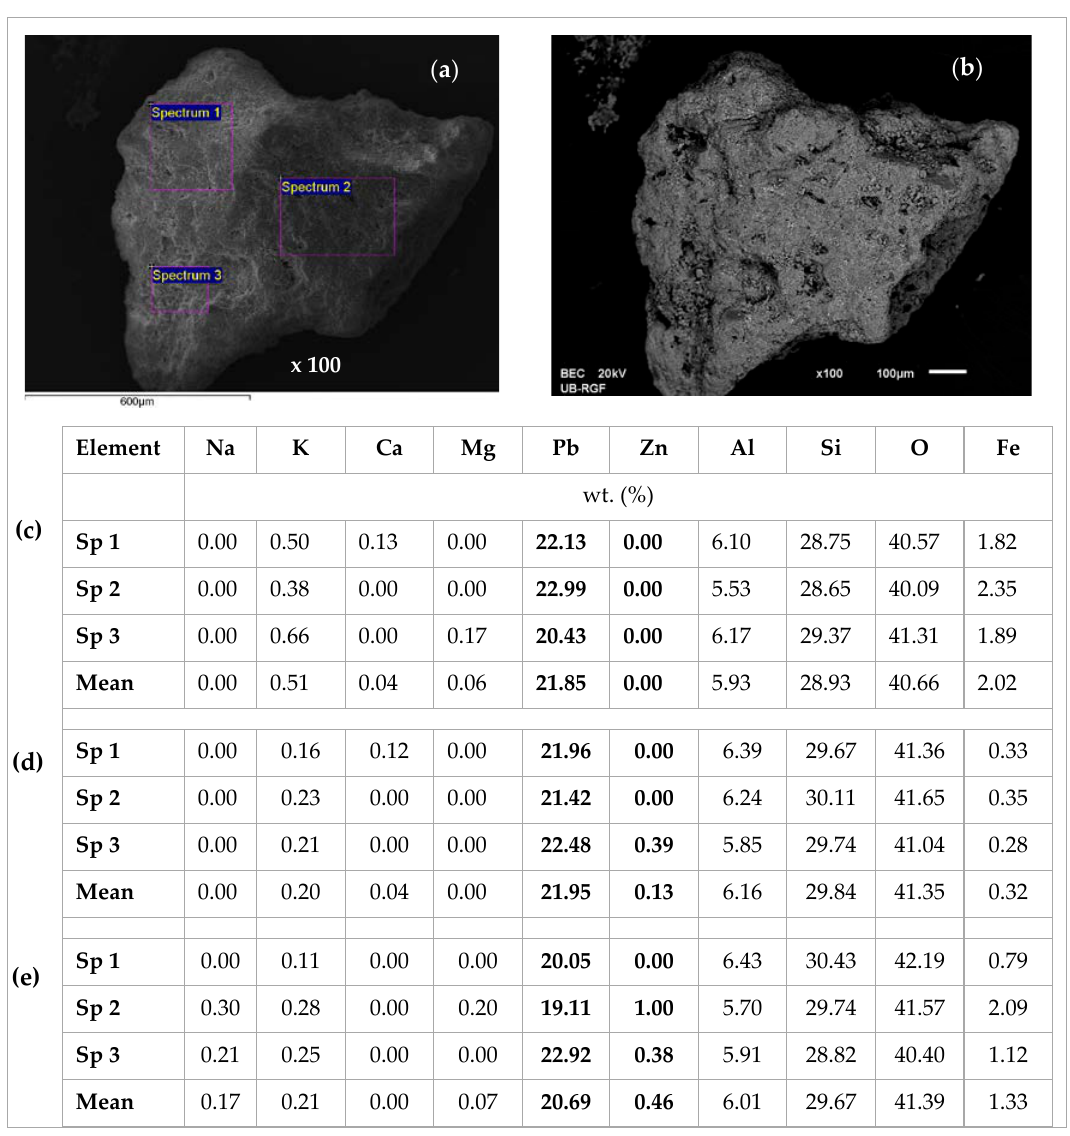
Figure 14 . SEM images of the first zeolite grain for the (Pb + Zn) system and Pb/Zn = 1.07: ( a ) SE image of the first grain with three spectrums (Sp) selected for EDS analysis; ( b ) Back-Scattered Electron (BSE) image of the first grain; ( c ) EDS analysis results of the first grain; ( d ) EDS analysis results of the second grain; (e) EDS analysis results [ 42 ] of the third grain.